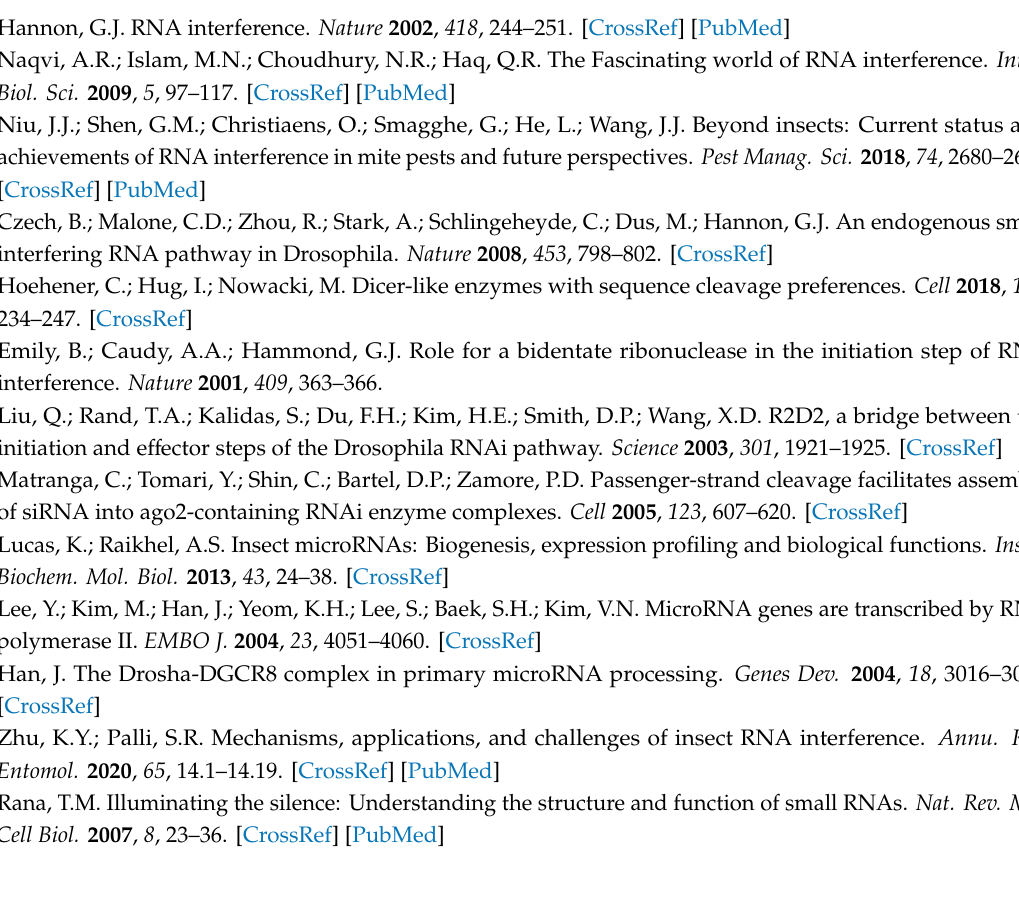
Table S1: Primers used for dsRNA synthesis and RT-qPCR, Table S2: Accession number of genes used in this study, Figure S1: The relative mRNA expression profiles of Hunchback upon ds HB administration, Figure S2: Relative expression profiles of miR-3024 upon miR-3024 agomir / antagomir